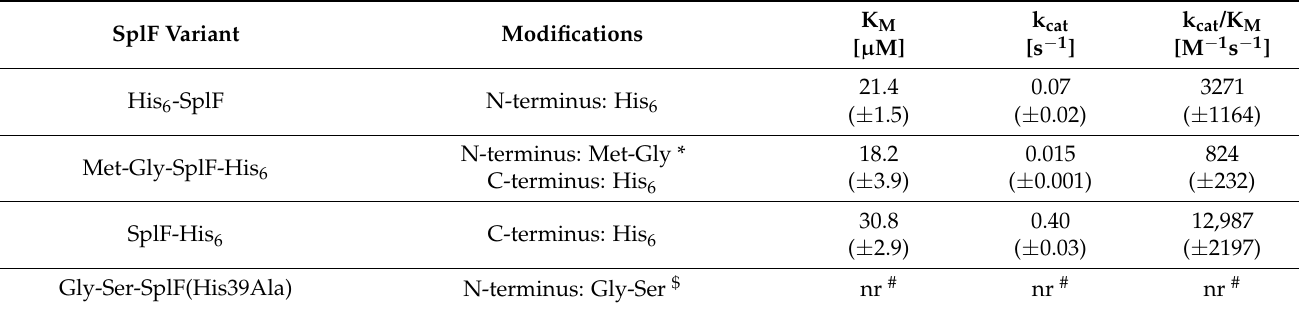
Table 1. Kinetics of ABZ-Tyr-Met-Leu-Ser-ANB-NH 2 hydrolysis by different SplF protease